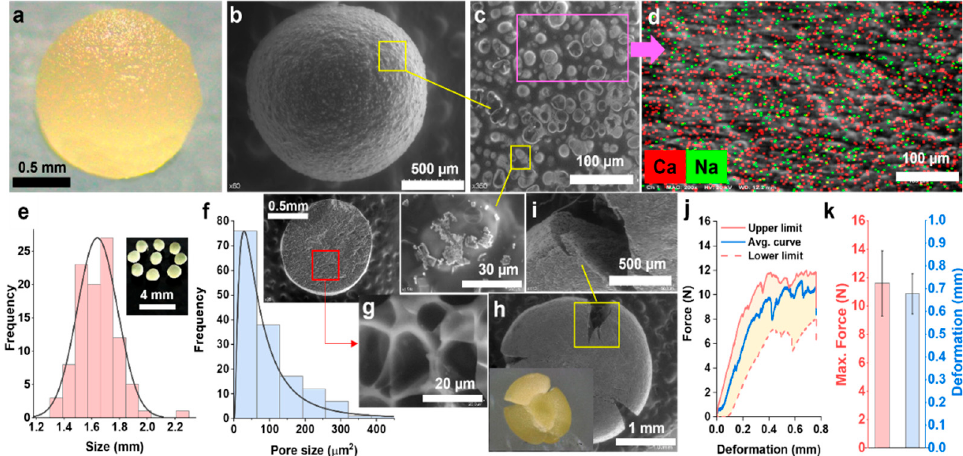
Figure 3. Experimental characterisation of WCO capsules: ( a ) Optical image of capsule; ( b ) SEM image of capsule; ( c ) SEM detail image of polynuclear surface structure of capsule; ( d ) SEM-EDS observation on the capsule surface; ( e ) Frequency histogram of the size of capsules with Normal fitting; ( f ) Frequency histogram of the pore size of internal structure of capsules with Log-normal fitting; ( g ) SEM image of the multicavity (egg-box) structure into capsules; ( h ) SEM image of an individual broken capsule by uniaxial compression; ( i ) Detail by SEM image of the fracture type in the broken capsule; ( j ) Force and deformation average curves of the compression tests; and ( k ) Average values of the max. compression force and deformation registered by the capsules tested by a load cell of 1 kN at a speed rate of 0.2 mm/min.